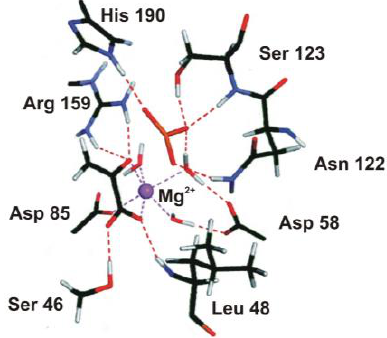
Figure 7. Molecular graphics model of the transition state in the reaction catalyzed by phoshoenol-pyruvate (PEP) mutase (on the basis of Figure 3 by Xu and Guo [70]). Note the planar metaphosphate intermediate stabilized by hydrogen bonds to amino-acid residues of the active site.